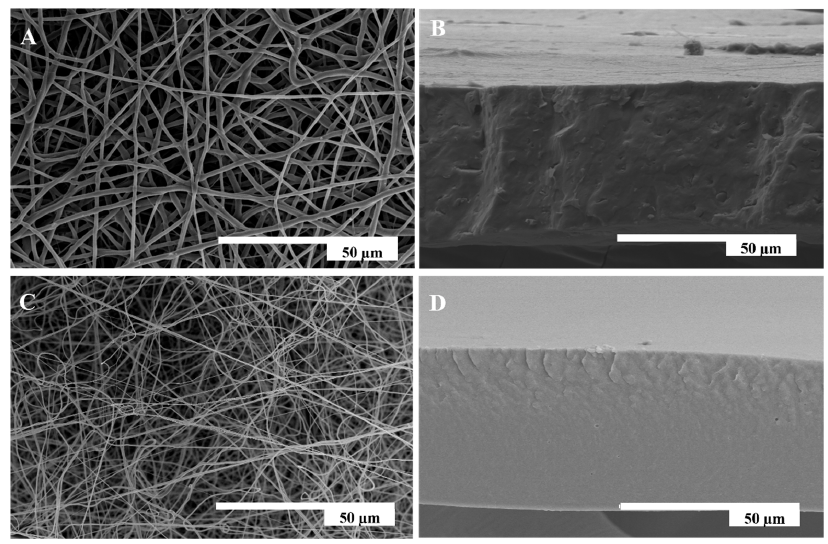
Figure 3. SEM images of the fibers and cross-section of the resulting films after annealing for ( A ) fibers of PHBV; ( B ) annealed PHBV film at 125 °C; ( C ) fibers of PA1010/1014; and ( D ) annealed PA1010/1014 film at 120 °C.